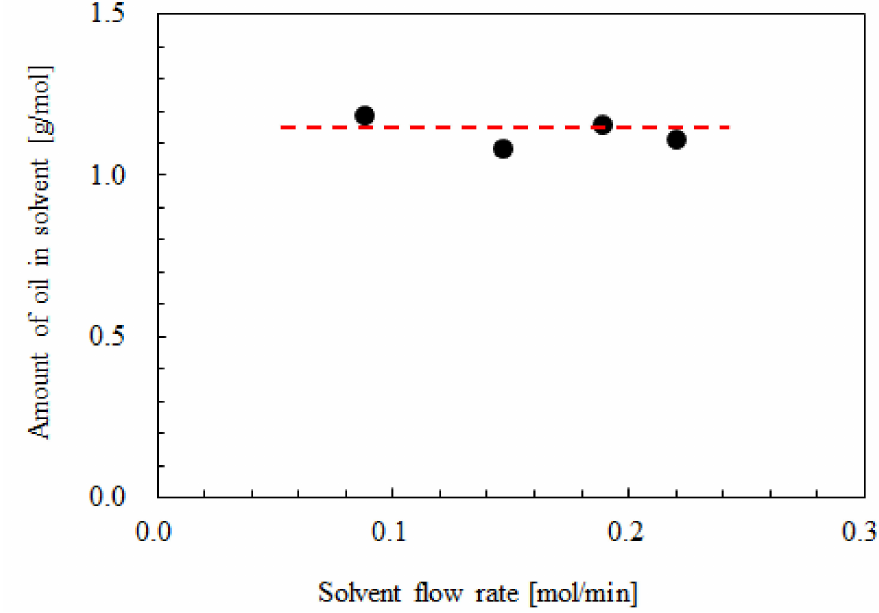
Figure 5. Relationship between the amount of oil in the solvent and the solvent flow rate at 25 ◦ C,